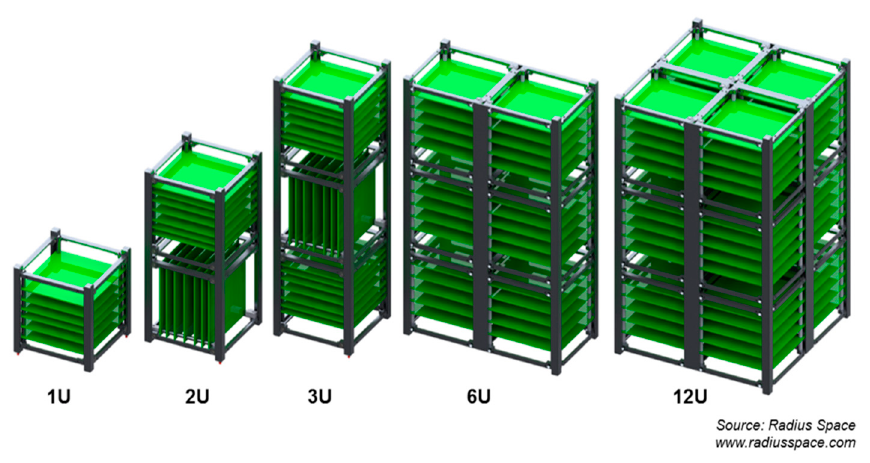
Figure 3. Illustration of the different CubeSat platforms.